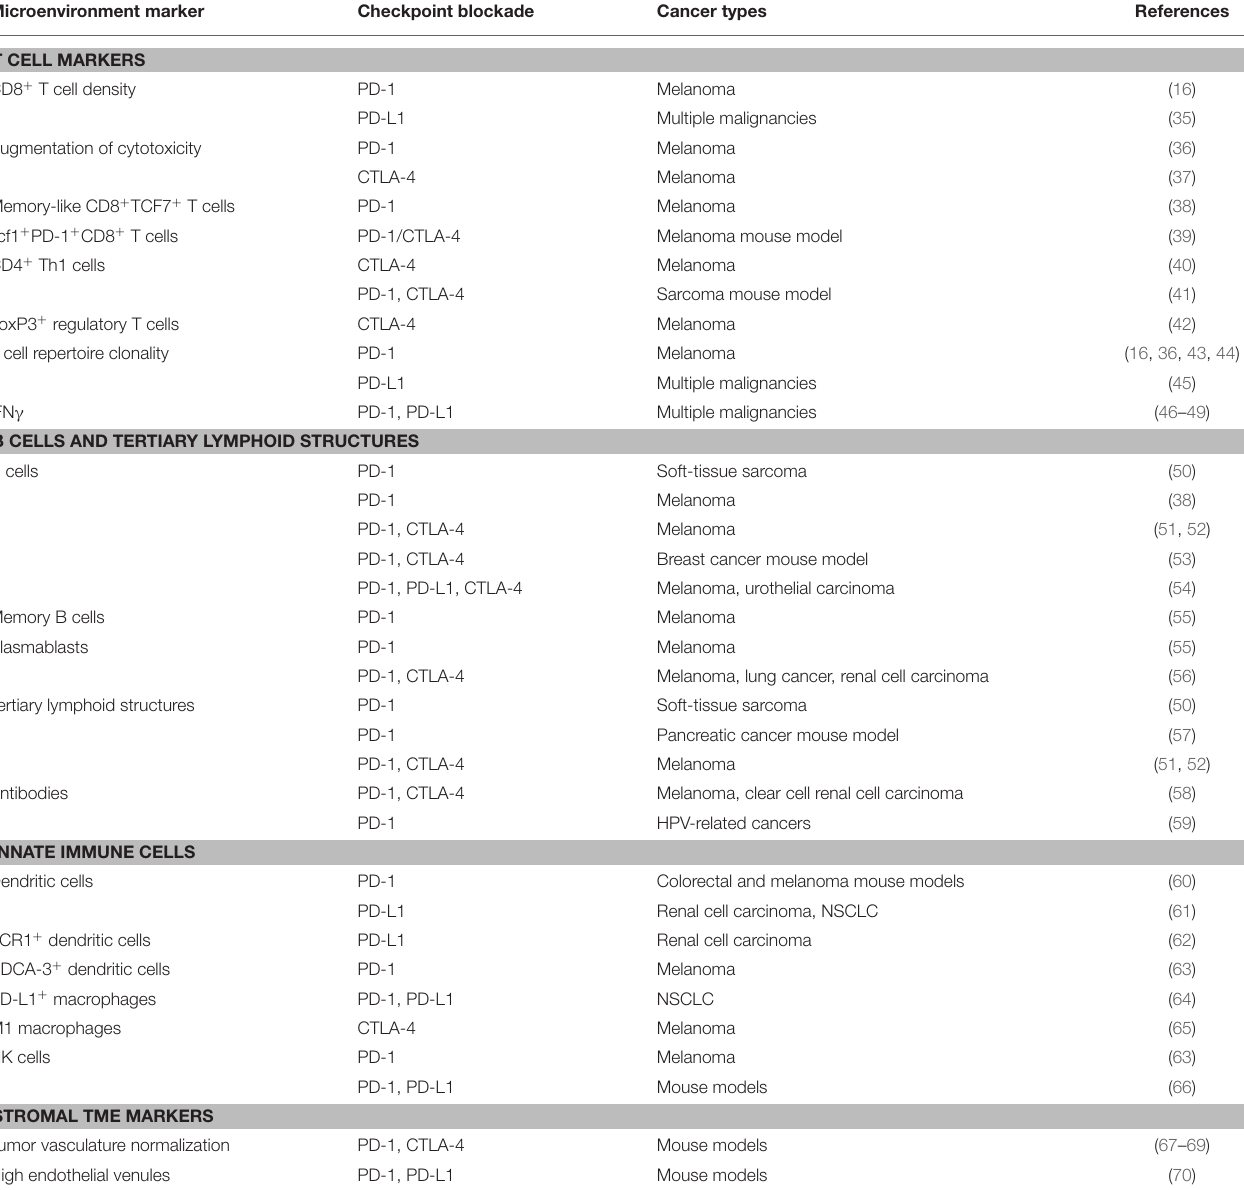
TABLE 1 | Summary of TME components associated with response to immune checkpoint